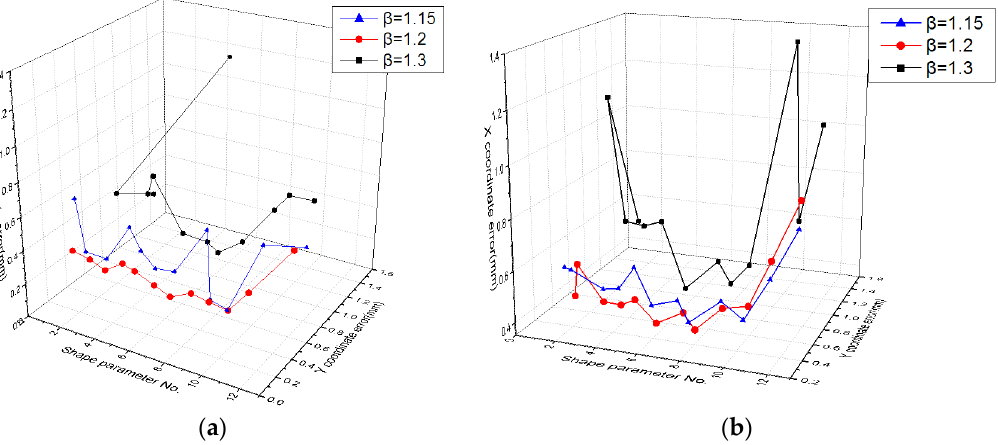
Figure 10. Fitting error of the MQ function with different values of the shape parameter in different partitions of unity for ( a ) the calibration data set and the ( b ) test data set.